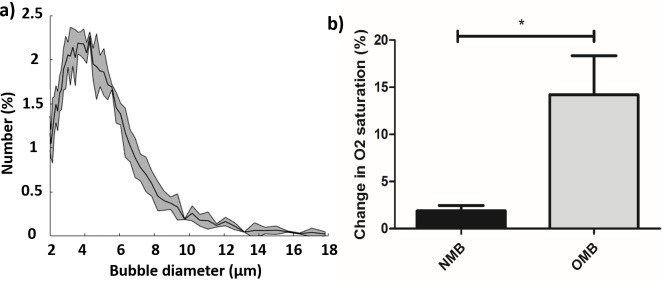
In vitro oxygen microbubble characterization.a) Measured oxygen microbubble size distribution, displayed with a diameter bin size of 0.032 μm, as mean ± standard deviation (gray area) from 3 independent samples; b) Measured change in oxygen % saturation in vitro after 300 μL OMB (n = 3) or NMB (n = 3) injection into 70 mL partially degassed water (p<0.05).